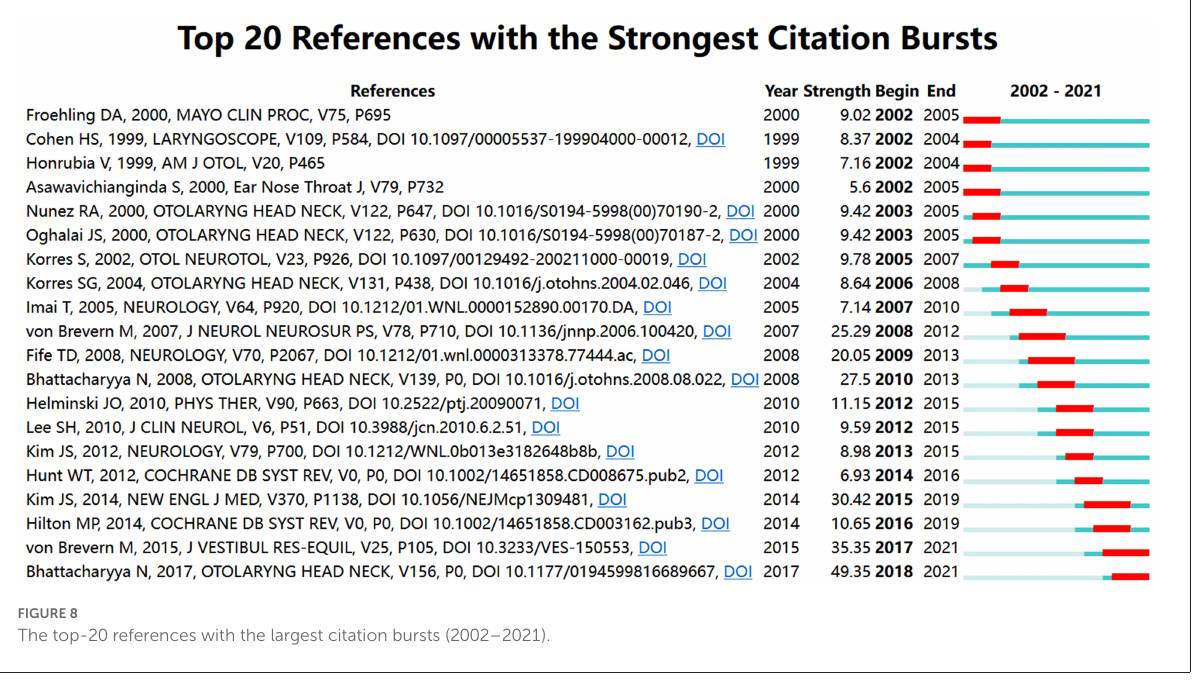
TABLE 5 The top-10 most prolific journals for publications related to